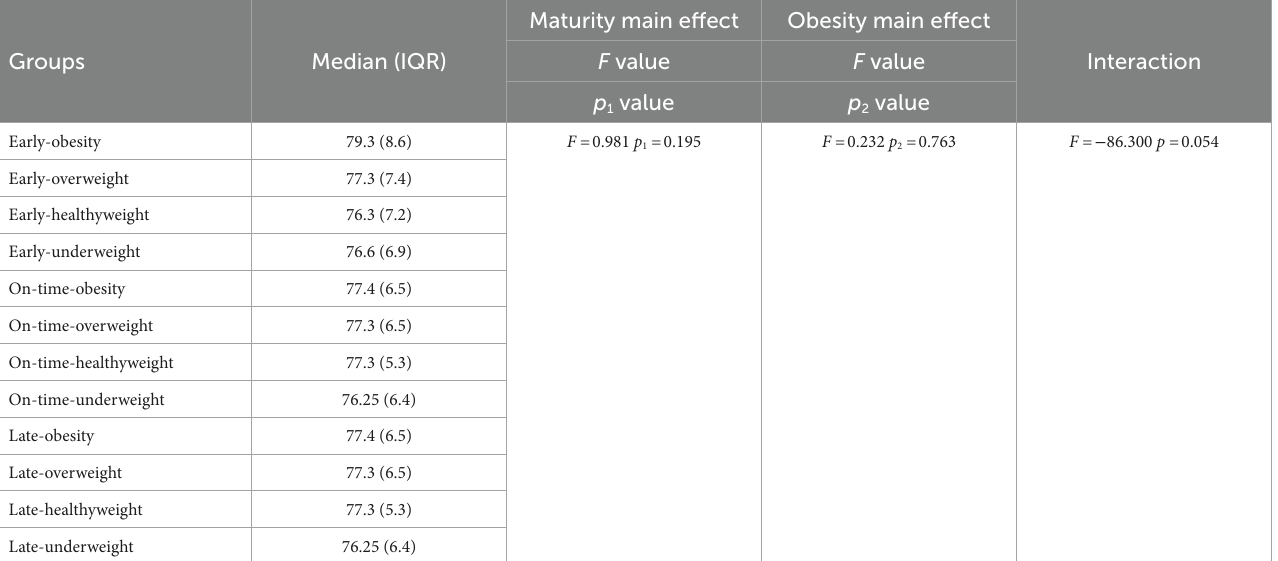
TABLE 4 Changes in the sitting height of the participants according to the maturity and obesity groups.